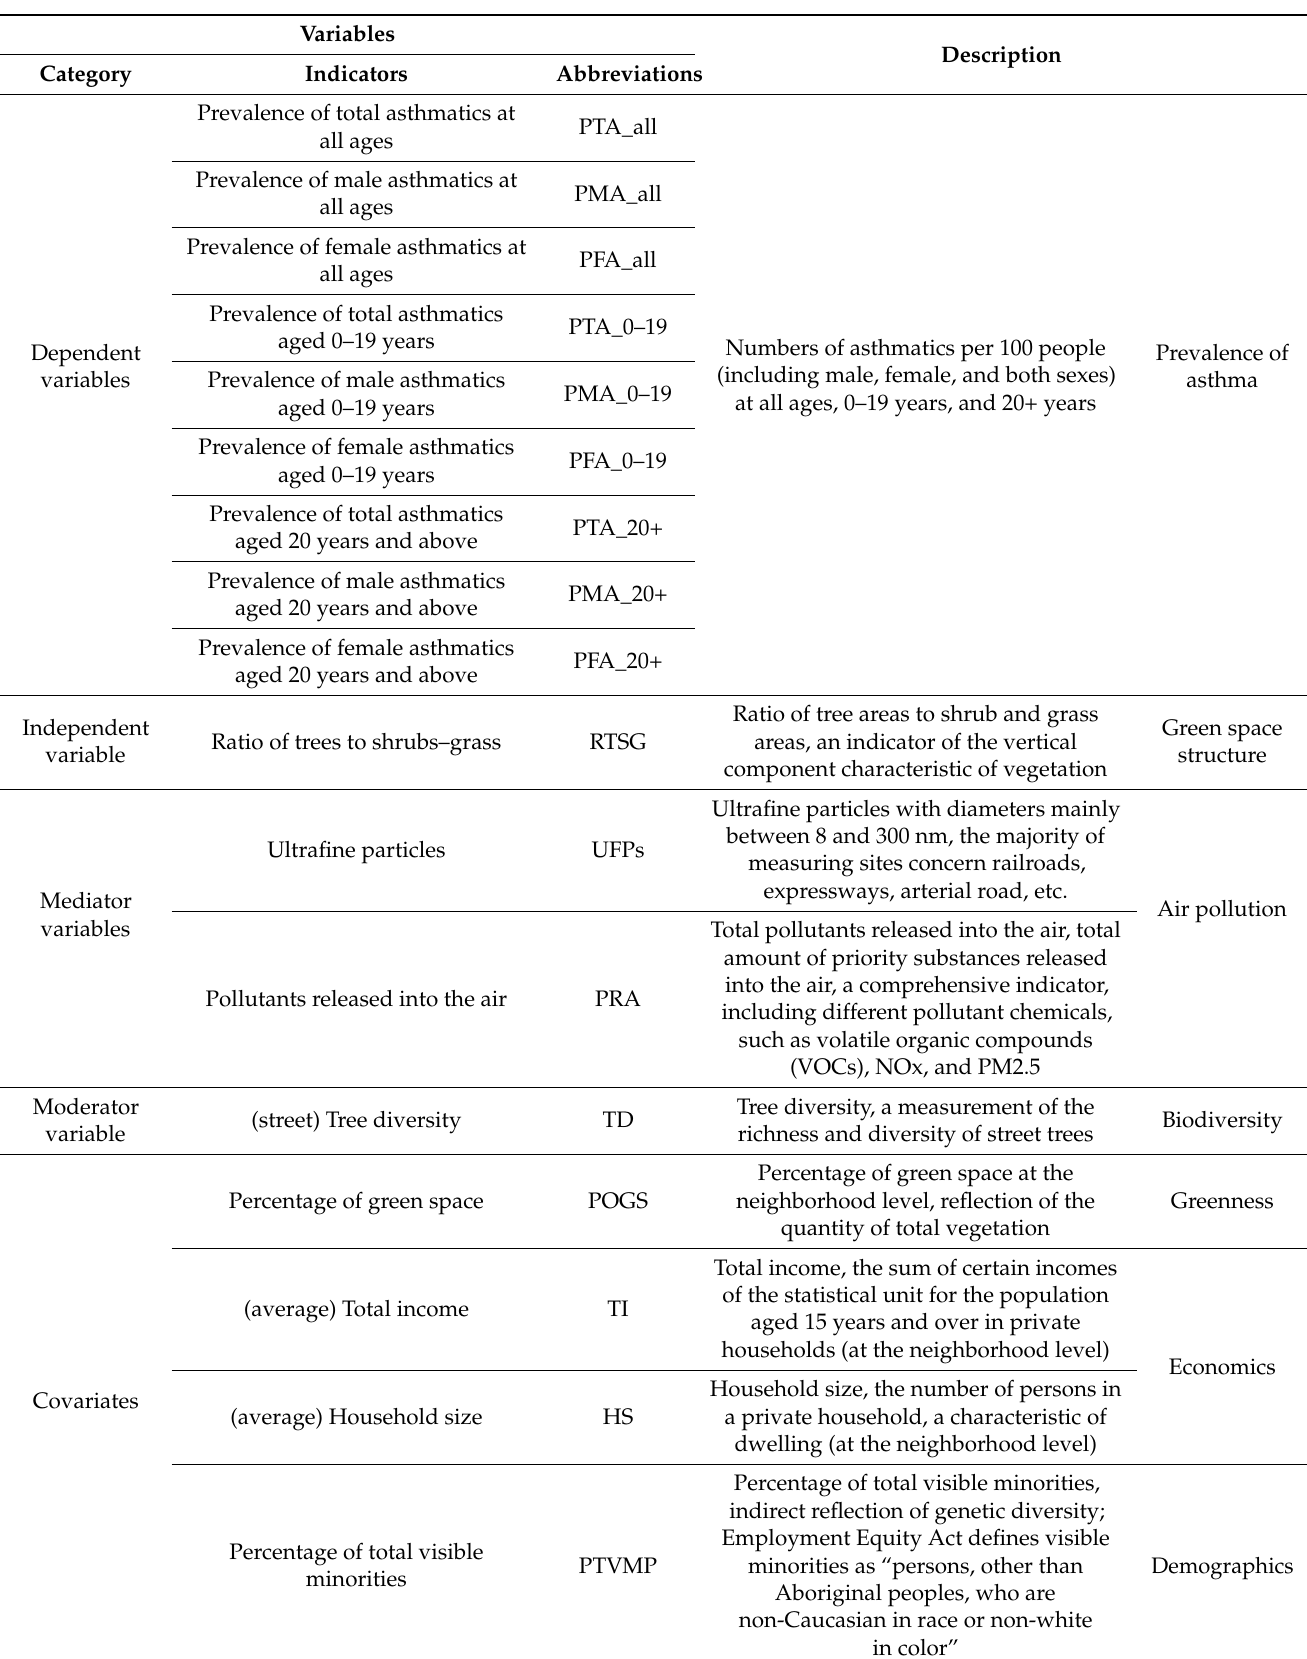
Table 1. The description of